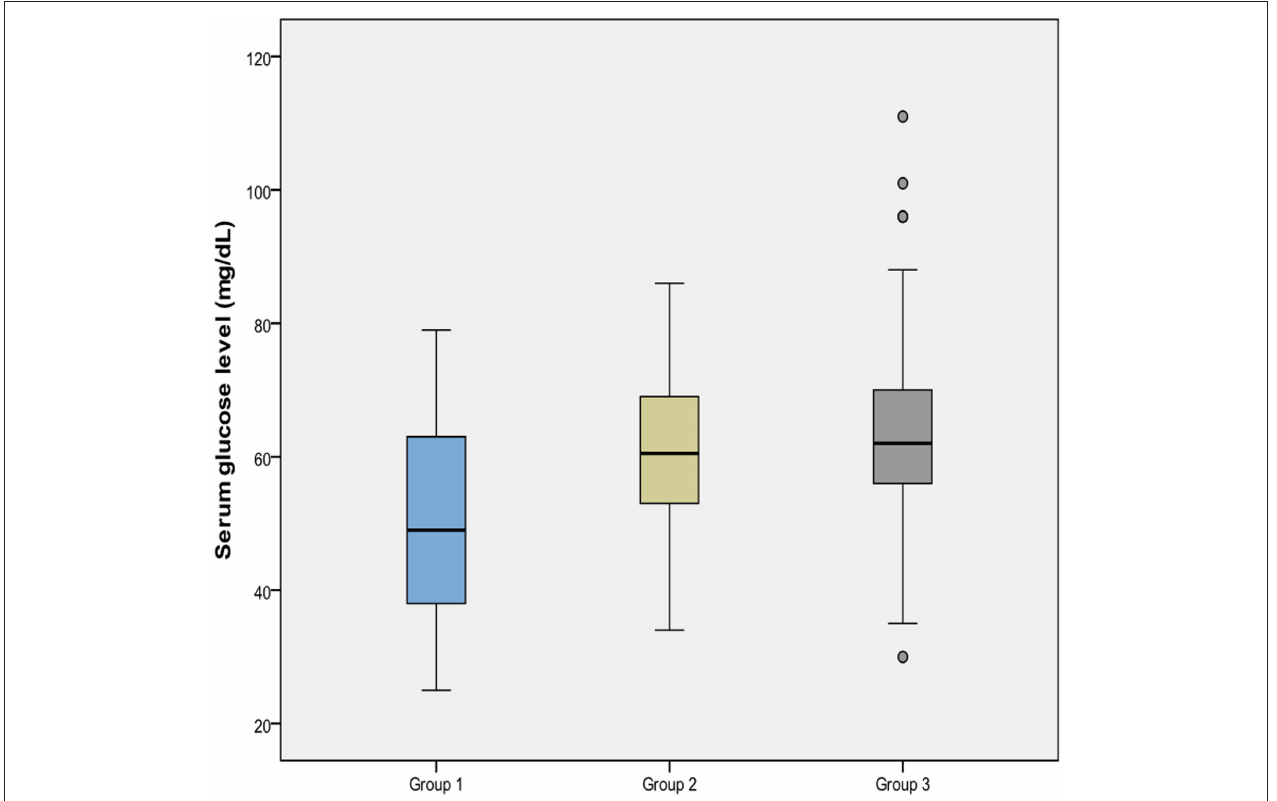
FIGURE 2 | Comparison of serum glucose levels of the groups.